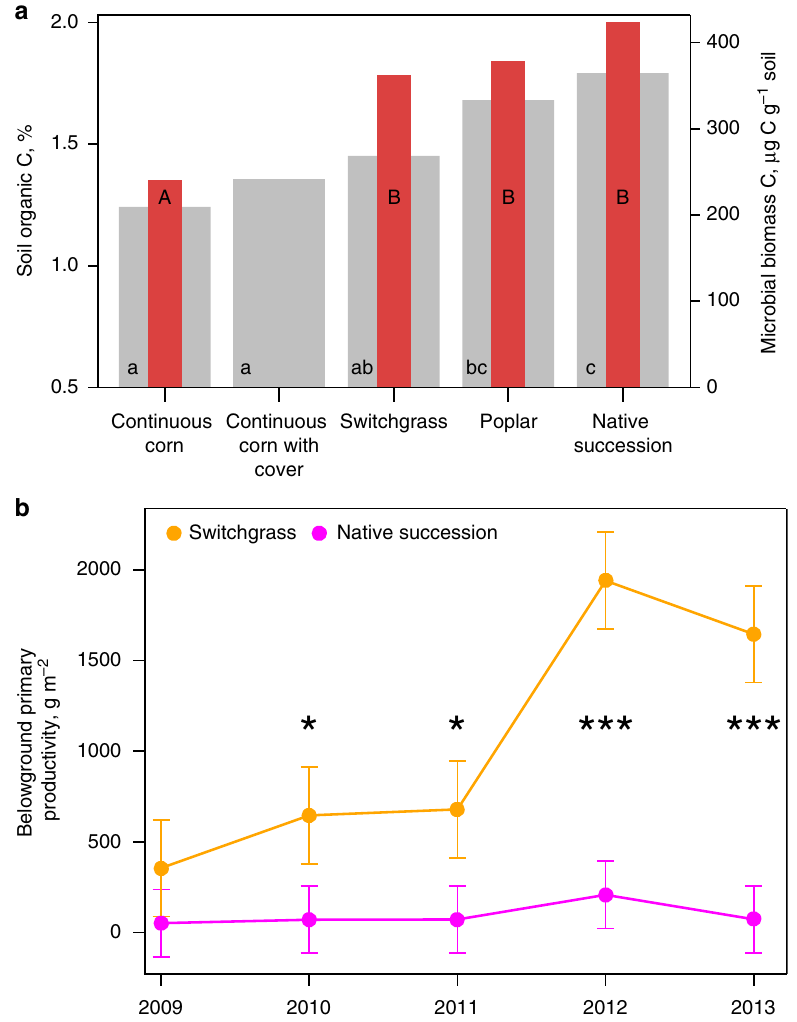
Fig. 1 Soil organic C, microbial biomass C, and belowground primary productivity in soil of the studied cropping systems 9 years after their implementation. a Average soil organic C (gray) and microbial biomass C (red) for fi ve studied systems (5 – 10 cm soil depth). Lower and upper case letters represent statistically signi fi cant differences in terms of soil organic C and microbial biomass C, respectively ( p < 0.05). Standard errors are equal to 0.1% and 28.5 µ g C g − 1 for soil organic C and microbial biomass C, respectively. Note that microbial biomass C could not be analyzed in the continuous corn with cover crop system. b Average belowground primary productivity for switchgrass and native succession vegetation systems from 2009 (the year of establishment) till 2013 (0 – 10 cm soil depth). Error bars represent s.e.m. Years when switchgrass belowground primary productivity exceeded that of native succession vegetation are marked with * p < 0.1 or *** p < 0.01. Source data are provided as a Source Data fi le